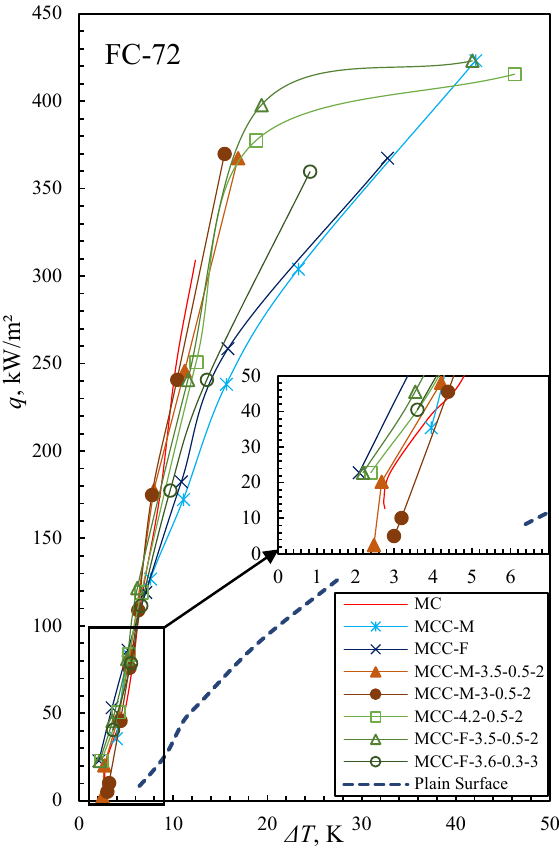
Fig. 8. Boiling curves for FC-72, heat flux vs